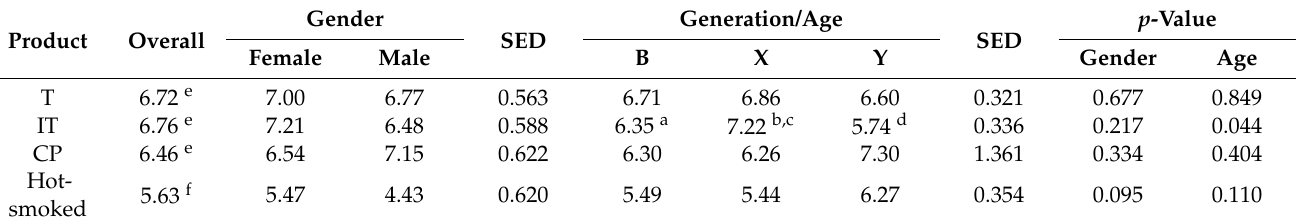
Table 3. Acceptability scores of blind product evaluation and effects of consumer gender and generation on acceptance of traditional and commercial